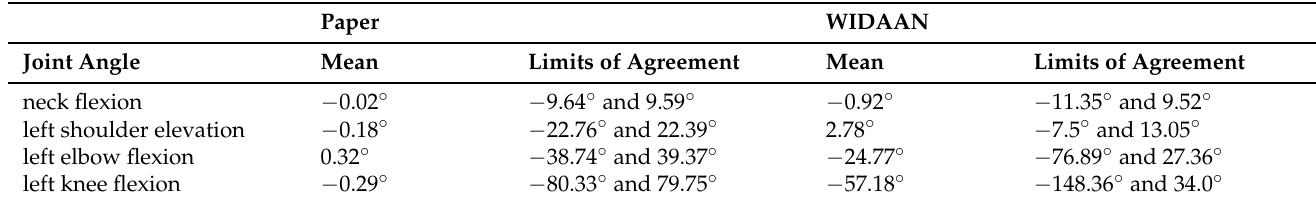
Table 5. Comparison of our results with WIDAAN results for tracker configuration 3 .